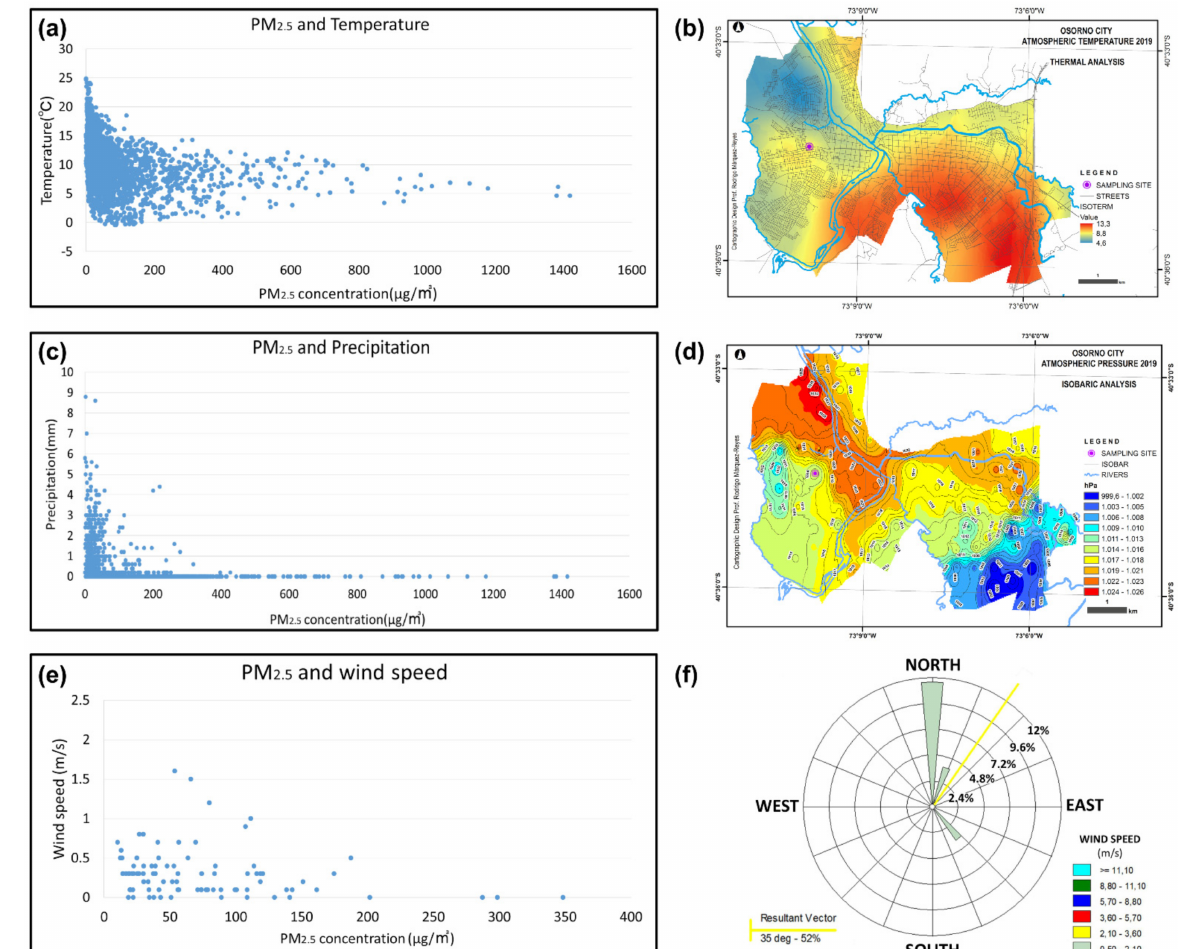
Figure 5. Correlation between PM 2.5 concentrations and some meteorological factors are indicated: ( a ) PM 2.5 and temperature, ( b ) thermal analysis in Osorno city, ( c ) PM 2.5 and precipitation, ( d ) atmo- spheric pressure of Osorno city with a color scale in hPa, ( e ) PM 2.5 and daily average wind speed, and ( f ) wind rose in Osorno city during moderate air quality index days. Purple dots in ( b , d ) indicate the Emprender-ULagos air monitoring station sampling site, with the horizontal scale of the bar at 1